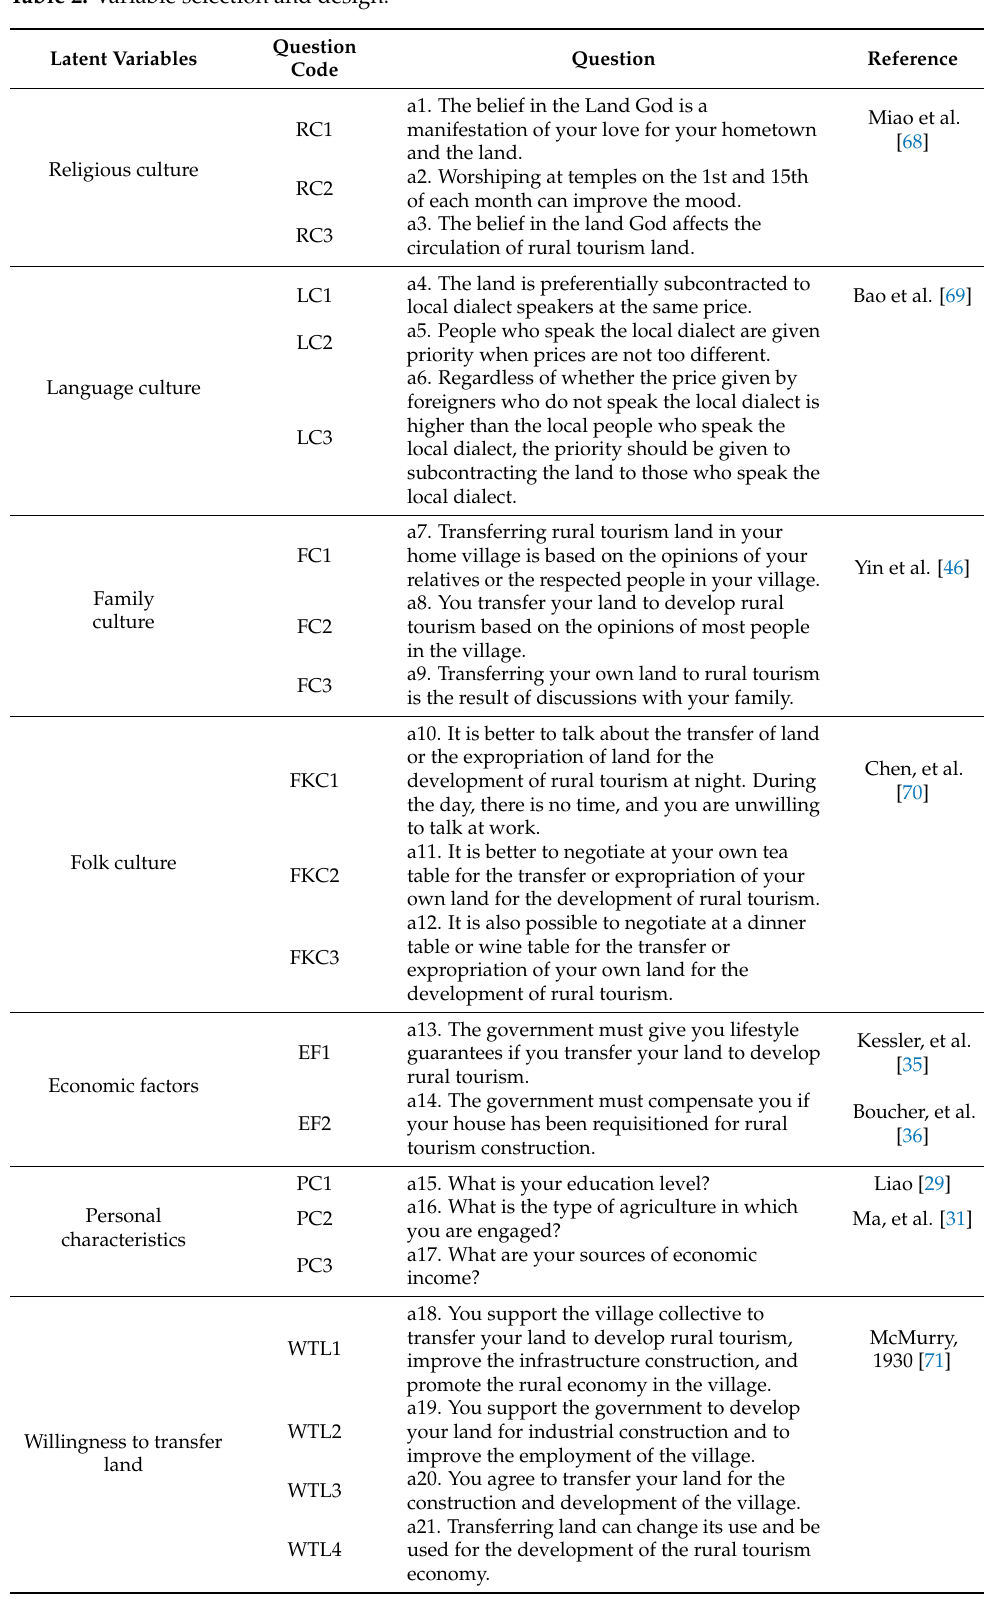
Table 2. Variable selection and